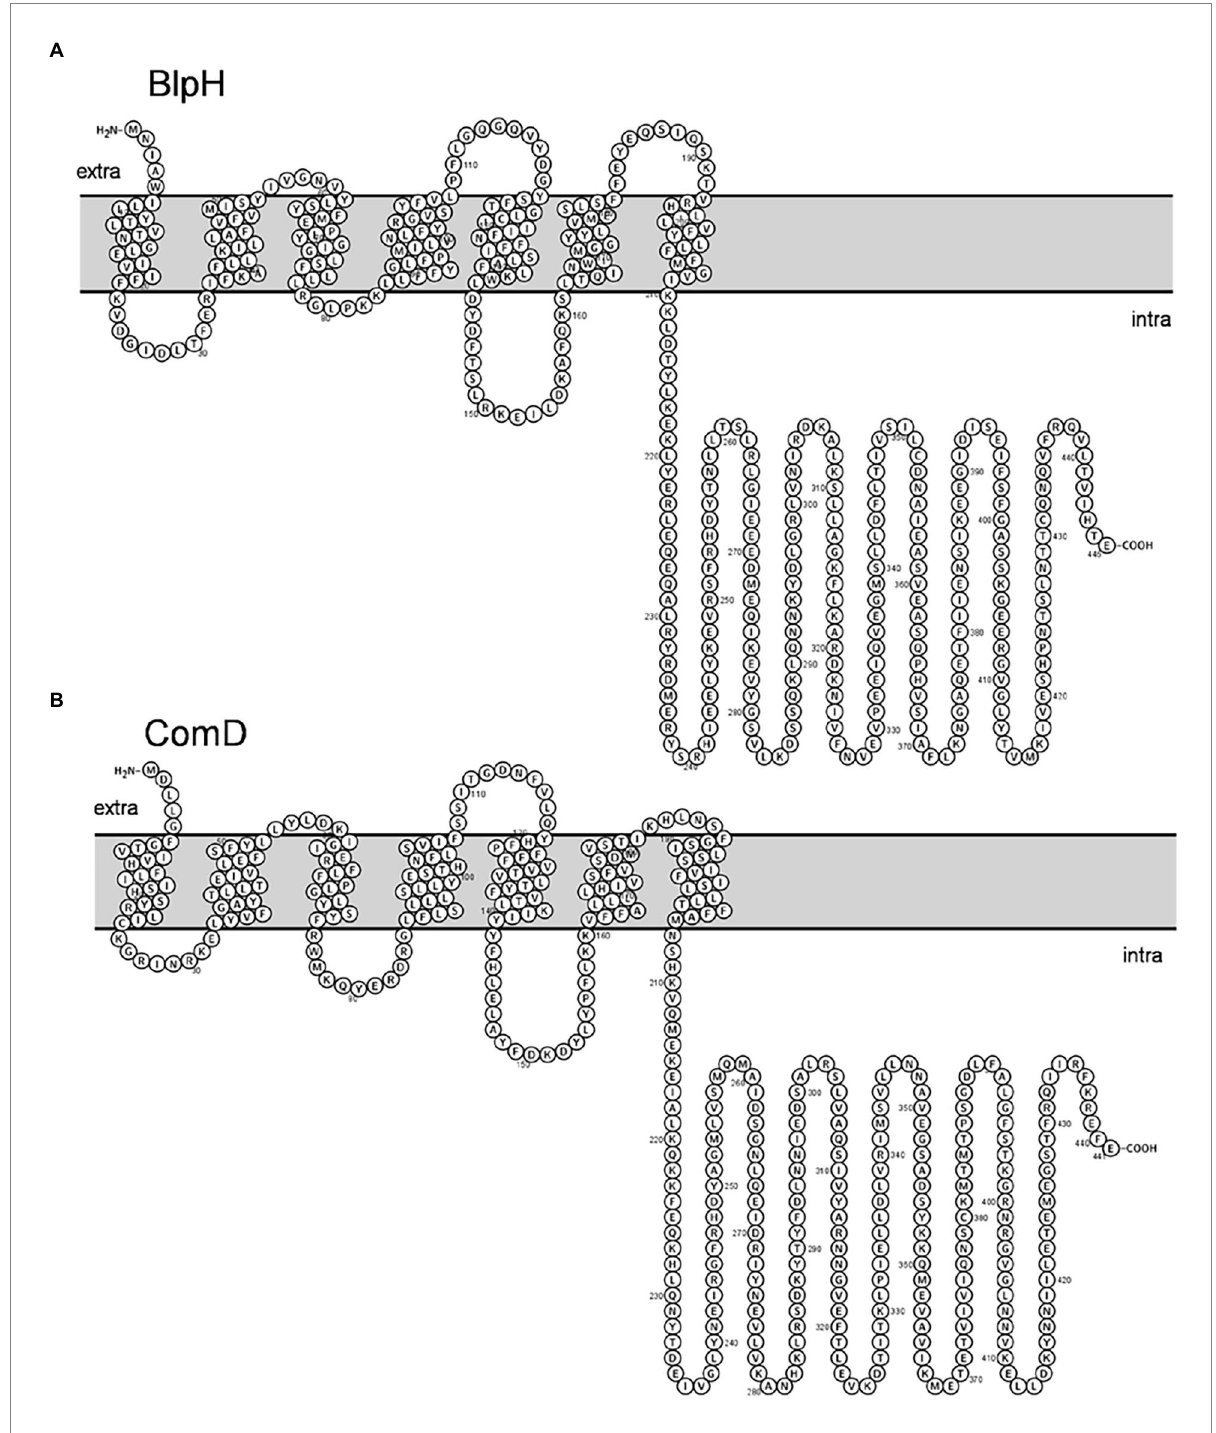
FIGURE 7 Membrane topology of (A) BlpH and (B) ComD. Topology was determined using Protter. Note that both BlpH and ComD contain three extracellular loops that are involved in signal